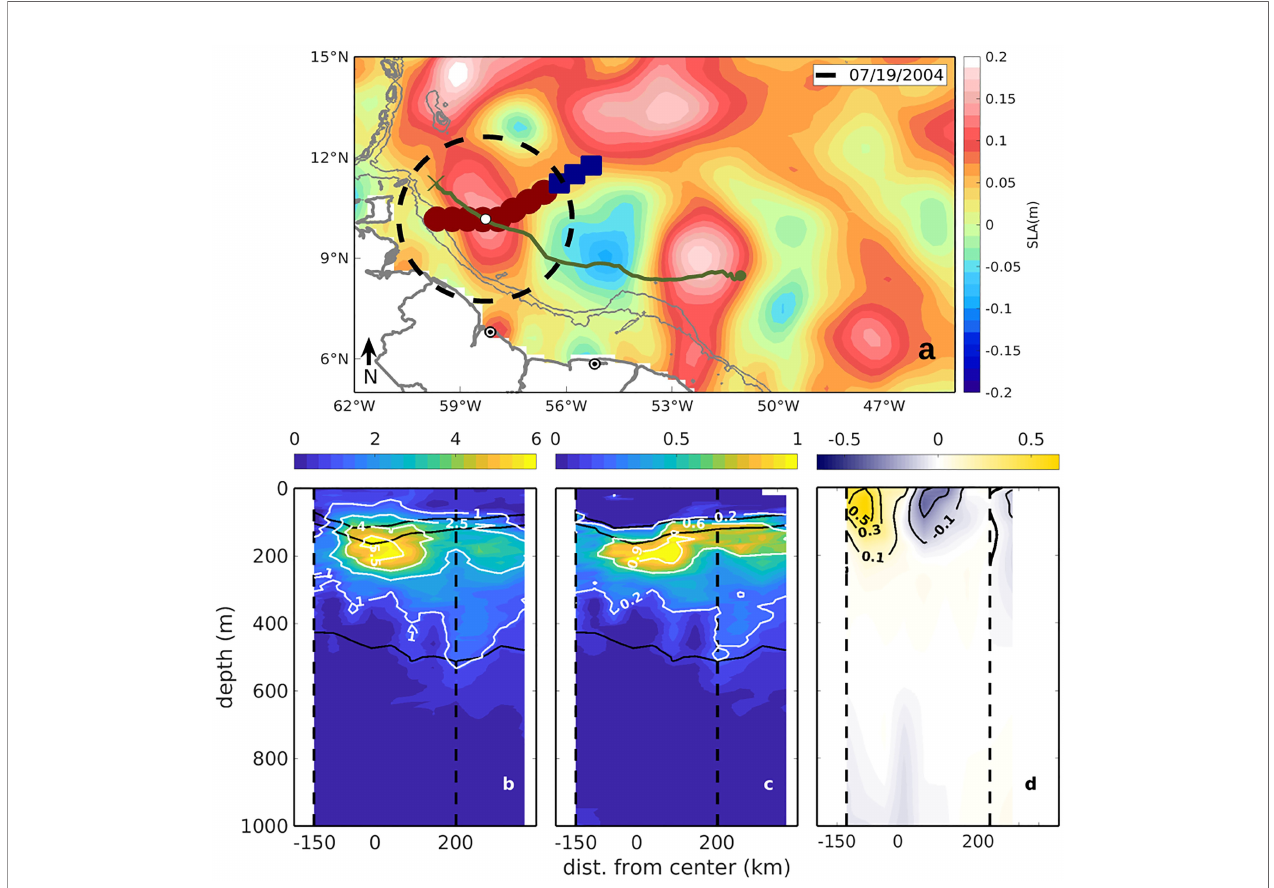
FIGURE 10 | Ring A seen as a positive sea level anomaly near 59°W in (A) . The green line is the ring trajectory from the META dataset; the dashed circle corresponds to twice the ring radius (2R), and the brown and blue markers are the positions of the IR and OR pro fi les, respectively. The T and S anomalies with respect to the ring exterior (the OR pro fi les) are presented in panels (B, C) together with the 24.5, 25.5 and 27.1 kgm - ³ isopycnals (black lines, from top to bottom); and the geostrophic velocities referred to 550db in panel (D) . The vertical dashed lines indicate the limits for the IR pro fi les. No smoothing was applied to the CTD